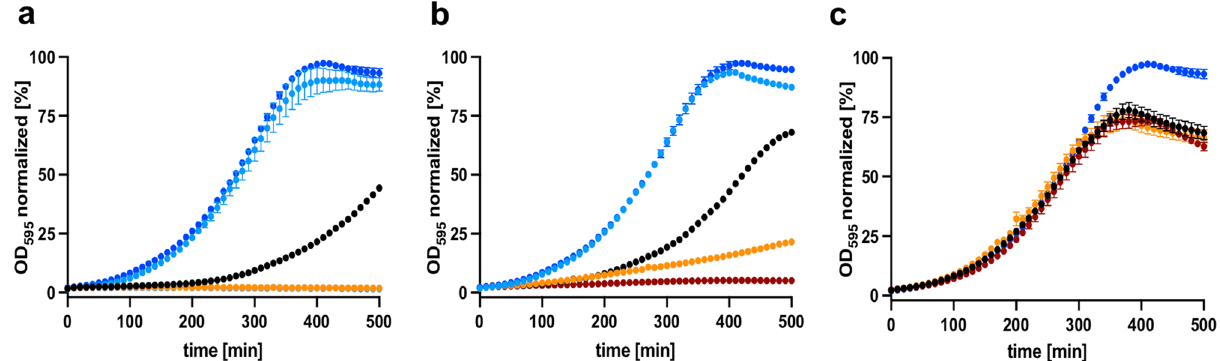
Figure 2. ( a ) Growth curve of the BceAB type ABC transporter expressing strain L. lactis NZ9000NsrFP (light blue), the ATP-hydrolysis deficient mutant strain L. lactis NZ9000NsrF H202A P (orange), the empty plasmid expressing strain L. lactis NZ9000Cm (black) and the nisin transporter expressing strain L. lactis NZ9000NisT (dark red) were induced with 0.3 nM nisin and treated with 1 µM bacitracin and 1 mM ZnCl 2 . As a control, L. lactis NZ9000NsrFP (dark blue) was induced with 0.3 nM nisin, and 1 mM ZnCl 2 was added. ( b ) Growth curve of L. lactis NZ9000NsrFP (light blue), L. lactis NZ9000NsrF H202A P (orange), L. lactis NZ9000Cm (black), L. lactis NZ9000NisT (dark red) induced with 0.3 nM nisin and treated with an additional 4 µM bacitracin without ZnCl 2 . As a control, L. lactis NZ9000NsrFP (dark blue) was induced with 0.3 nM nisin. ( c ) Growth curve of the control, L. lactis NZ9000NsrFP (dark blue), L. lactis NZ9000Cm (black) and L. lactis NZ9000NisT (dark red) induced with 0.3 nM nisin, and 1 mM ZnCl 2 was added. The normalized OD 600 was plotted against the time using GraphPad Prism version 9.2.0 for Mac, GraphPad Software, San Diego, California USA, www. graph pad.